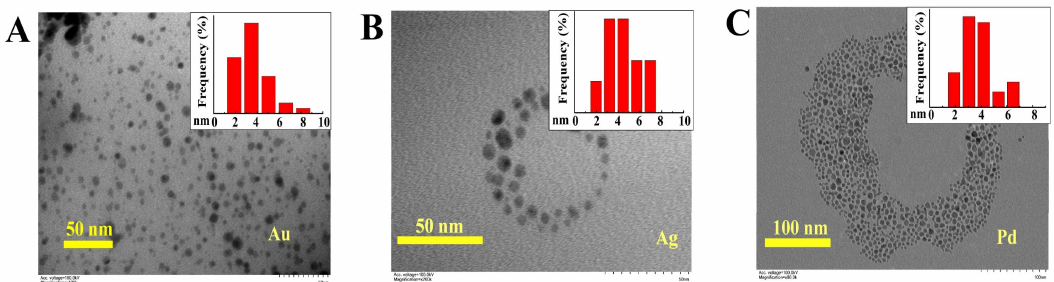
Figure 6. TEM images of nanoparticles of Au ( A ), Ag ( B ) and Pd ( C ) encapsulated within polymer 3 . The distribution of particle sizes is shown in the insert of each